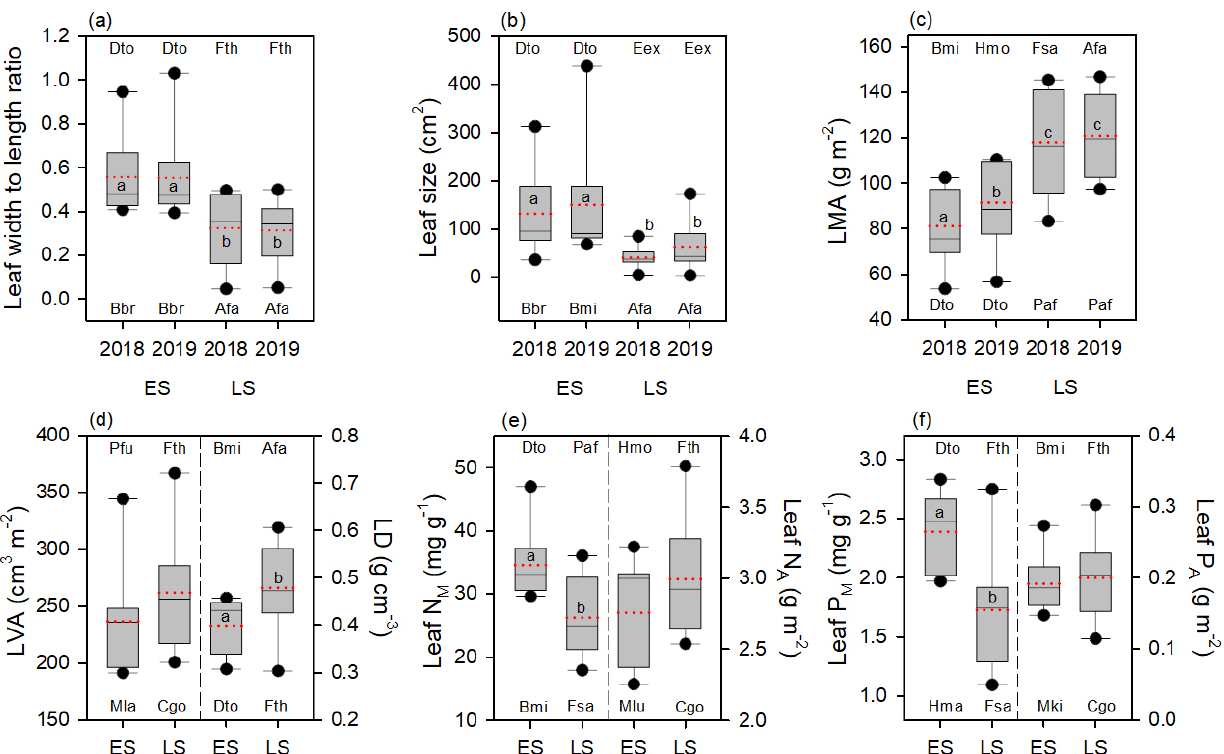
Figure 1. ( a – f ) Leaf characteristics of 18 species at high-elevation site (Sigira). ( a ) Leaf shape (i.e., leaf width to leaf length ratio: W/L), ( b ) leaf size, ( c ) leaf mass per unit area (LMA), ( d ) leaf volume per area (LVA), leaf density (LD), ( e ) leaf nitrogen (N) per unit mass (N M ) and area (N A ), and ( f ) leaf phosphorous (P) per unit mass (P M ) and area (P A ). Leaf shape, size and LMA ( a – c ) were measured in both 2018 and 2019. Leaf N and P were measured in 2018 and LVA and LD in 2019 only ( d – f ). The boxplot boundary indicates the 25th and 75th percentile, the error bars indicate the 95th and 5th percentiles, the black solid line and the red dotted lines inside the boxes indicate median and mean, respectively. The black dots show the highest and lowest species means, for which species codes (see Table 1) are indicated in the lower and upper part of the figure. Different letters (a–c) inside boxes indicate significant differences ( p < 0.05) of the mean between early (ES) and late (LS) successional species and years when relevant.